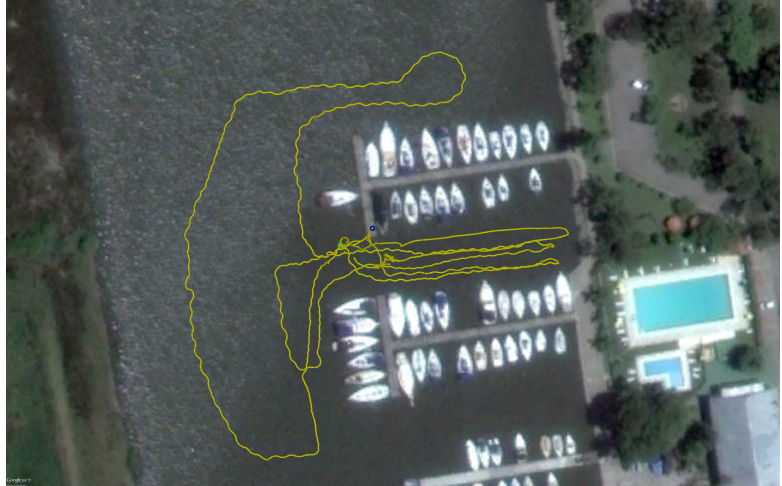
Figure 7. Satellite image of the harbor with the trajectory traveled by the Remote Operated Vehicle (ROV) during the acquisition of the Dataset ARACATI 2014 [20]. Map data: Google, DigitalGlobe 2016.